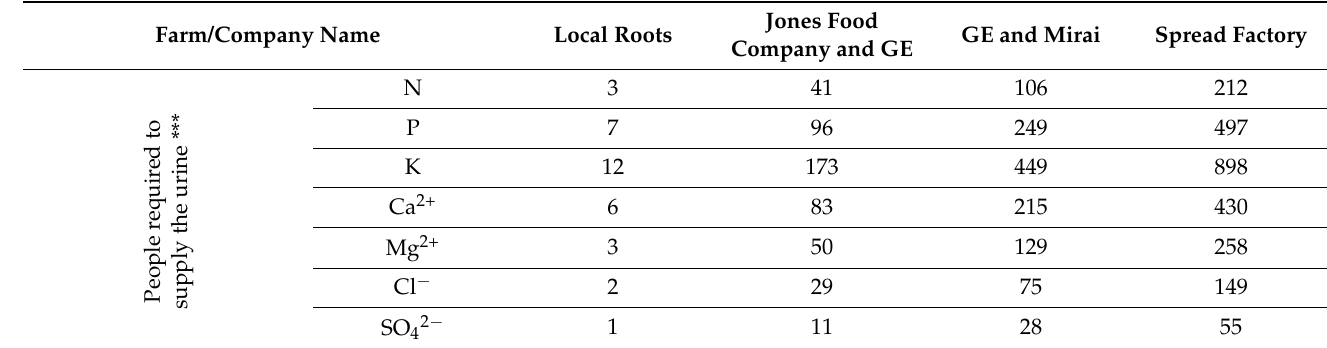
and real human urine. Table S2: Comparison between micro-nutrients content in synthetic urine